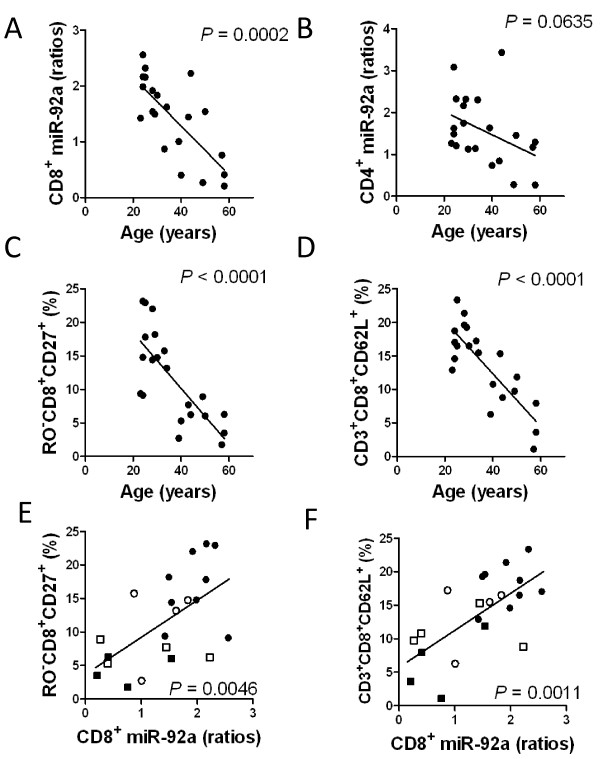
Correlation between T-lymphocyte miR-92a level and age. The CD8+ T-lymphocyte miR-92a level significantly decreased with age (A), while CD4+ lymphocytes only showed a tendency for a decrease of miR-92a level with age (B). A significant decrease in the percentage of RO-CD8+CD27+ fraction (C) or CD3+CD8+CD62L+ fraction (D) with age is evident. There is a significant positive correlation between CD8+ miR-92a level (x axis) and the percentage of RO-CD8+CD27+ fraction (E) and CD3+CD8+CD62L+ fraction (F) (y axis), which tends to down-regulate with age (closed circles = 20 to 29 years; open circles = 30 to 39 years; open squares = aged 40 to 49 years; closed squares = older than 50 years).